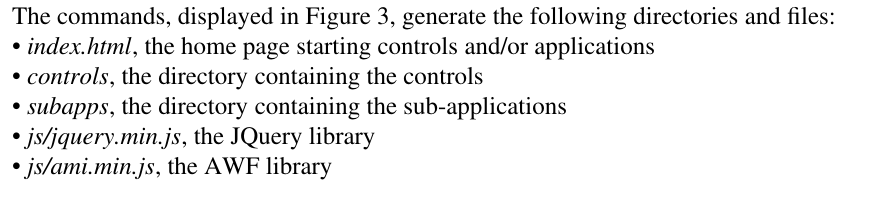
Fig. 3. AWF environment